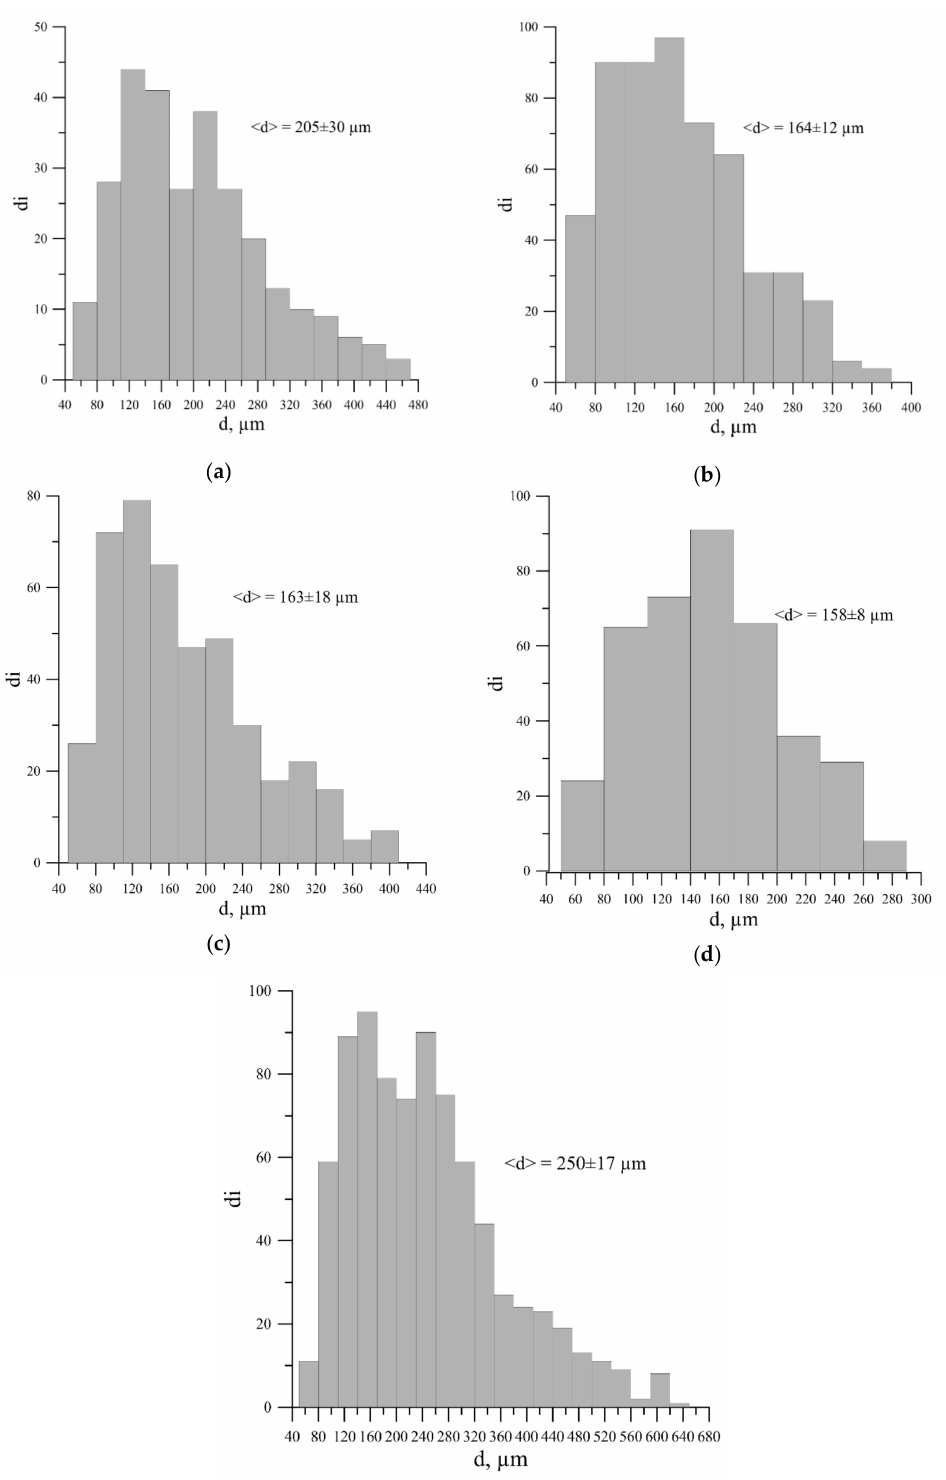
Figure 7. Grain distribution histograms of obtained alloys: AA5056 reference US ( a ), AA5056 + MA1 US ( b ), AA5056 + MA2 US ( c ), AA5056 + MA3 US ( d ), AA5056 + MA1 without US ( e ). The stress-strain diagrams obtained under uniaxial tension of flat samples from tested AA5056-based aluminum alloys are given in Figure